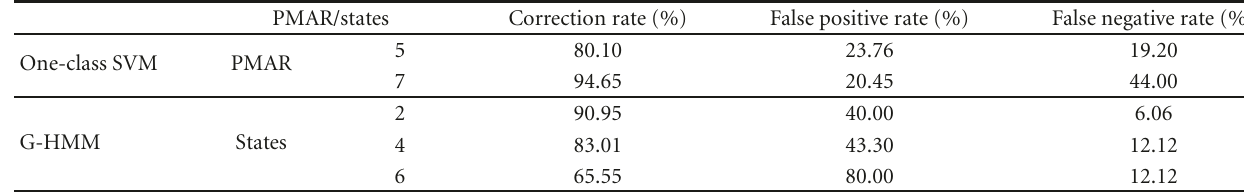
Table 5: The overall experiment results of one-class SVM versus G-HMM.